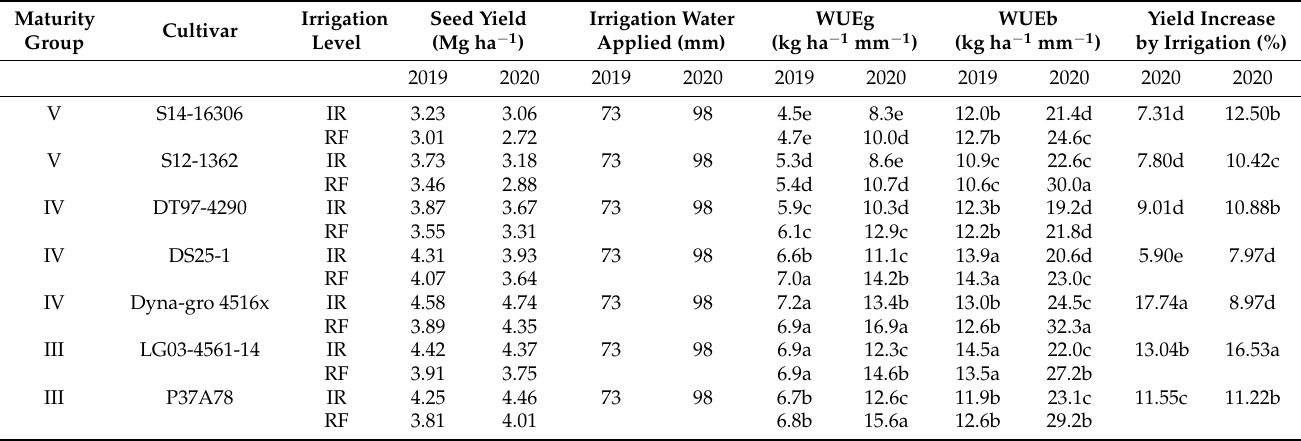
Table 6. Water use efficiency (WUE) for seed yield and aboveground biomass of maturity group III, IV, and V soybean cultivars in irrigated and rainfed treatments. Precipitation recorded in 2019 active crop season was 638 mm, and 2020 was 272